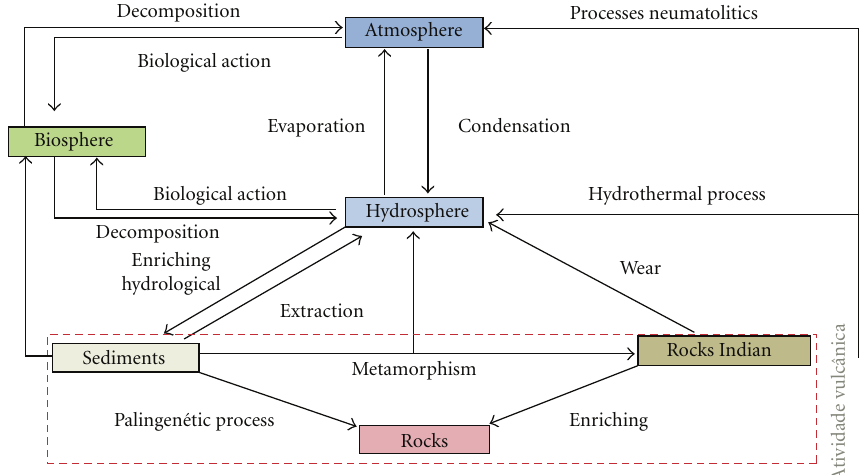
Figure 3: Cycle of mercury in the environment. Modified from Azevedo and Chasin 2003 [53]. Scheme demonstrating constant flow of mercury compounds in the hydrosphere, lithosphere, atmosphere, and